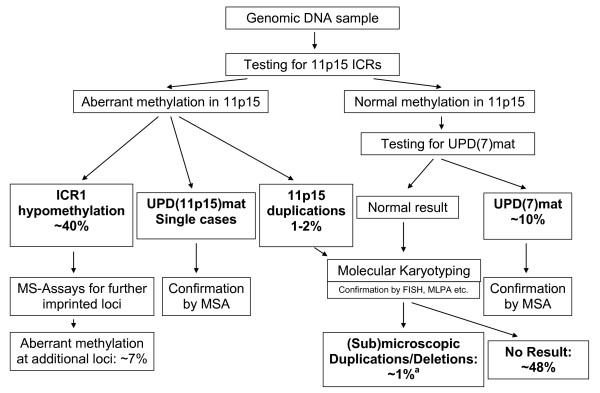
Diagnostic algorithm in children diagnosed as SRS. The algorithm should comprise MS-MLPA for the 11p15 loci and UPD(7)mat testing for loci on both arms of the chromosome. (a the ratio is roughly estimated due to the limited numbers of systematic studies aiming on submicroscopic imbalances in SRS; MSA: microsatellite analysis; MS assays: methylation-specific assays)